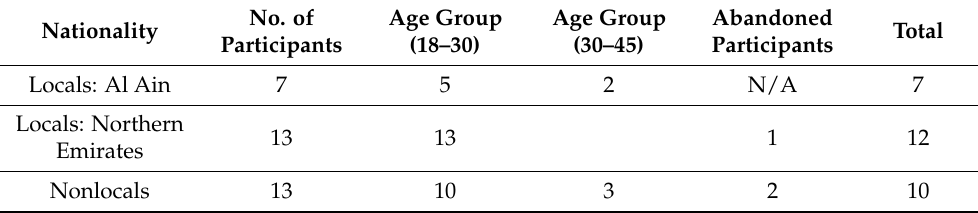
Table 3. Participants’